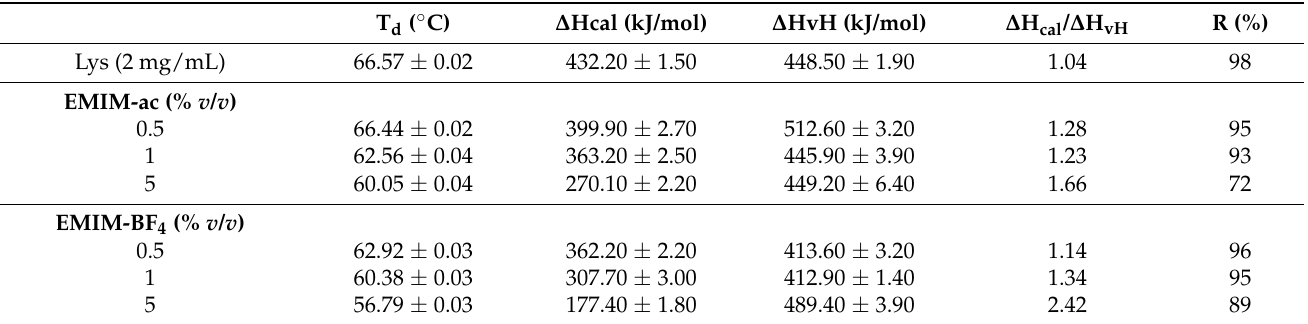
Table 2. Thermodynamics parameters derived from DSC thermograms depicted in Figure 2. R = reversibility